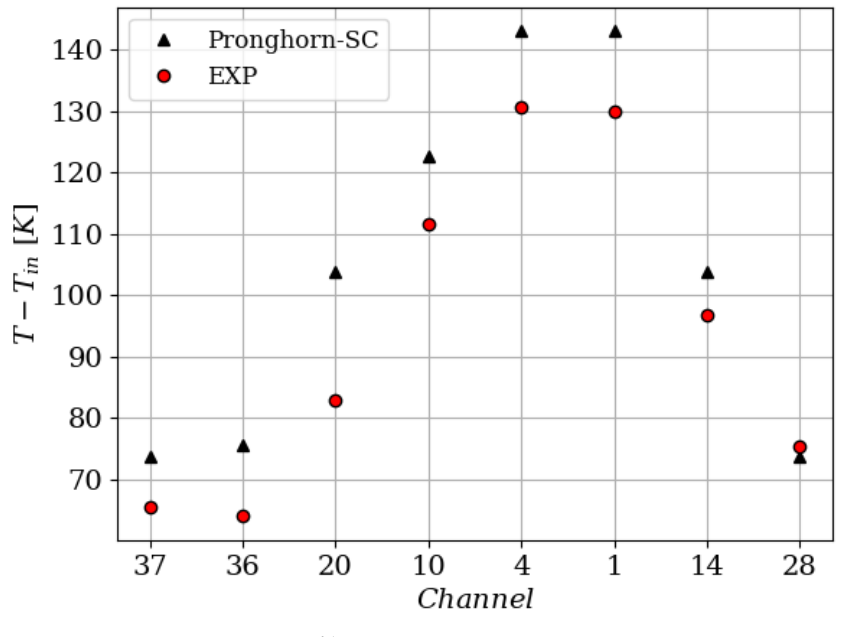
Figure 16. Exit temperature